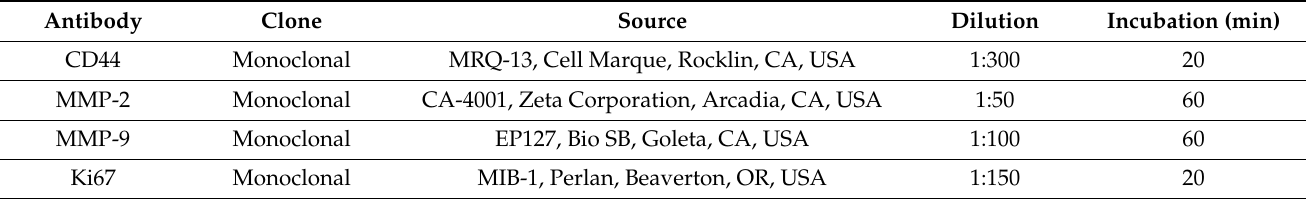
Table 1. Details of the primary antibodies used for